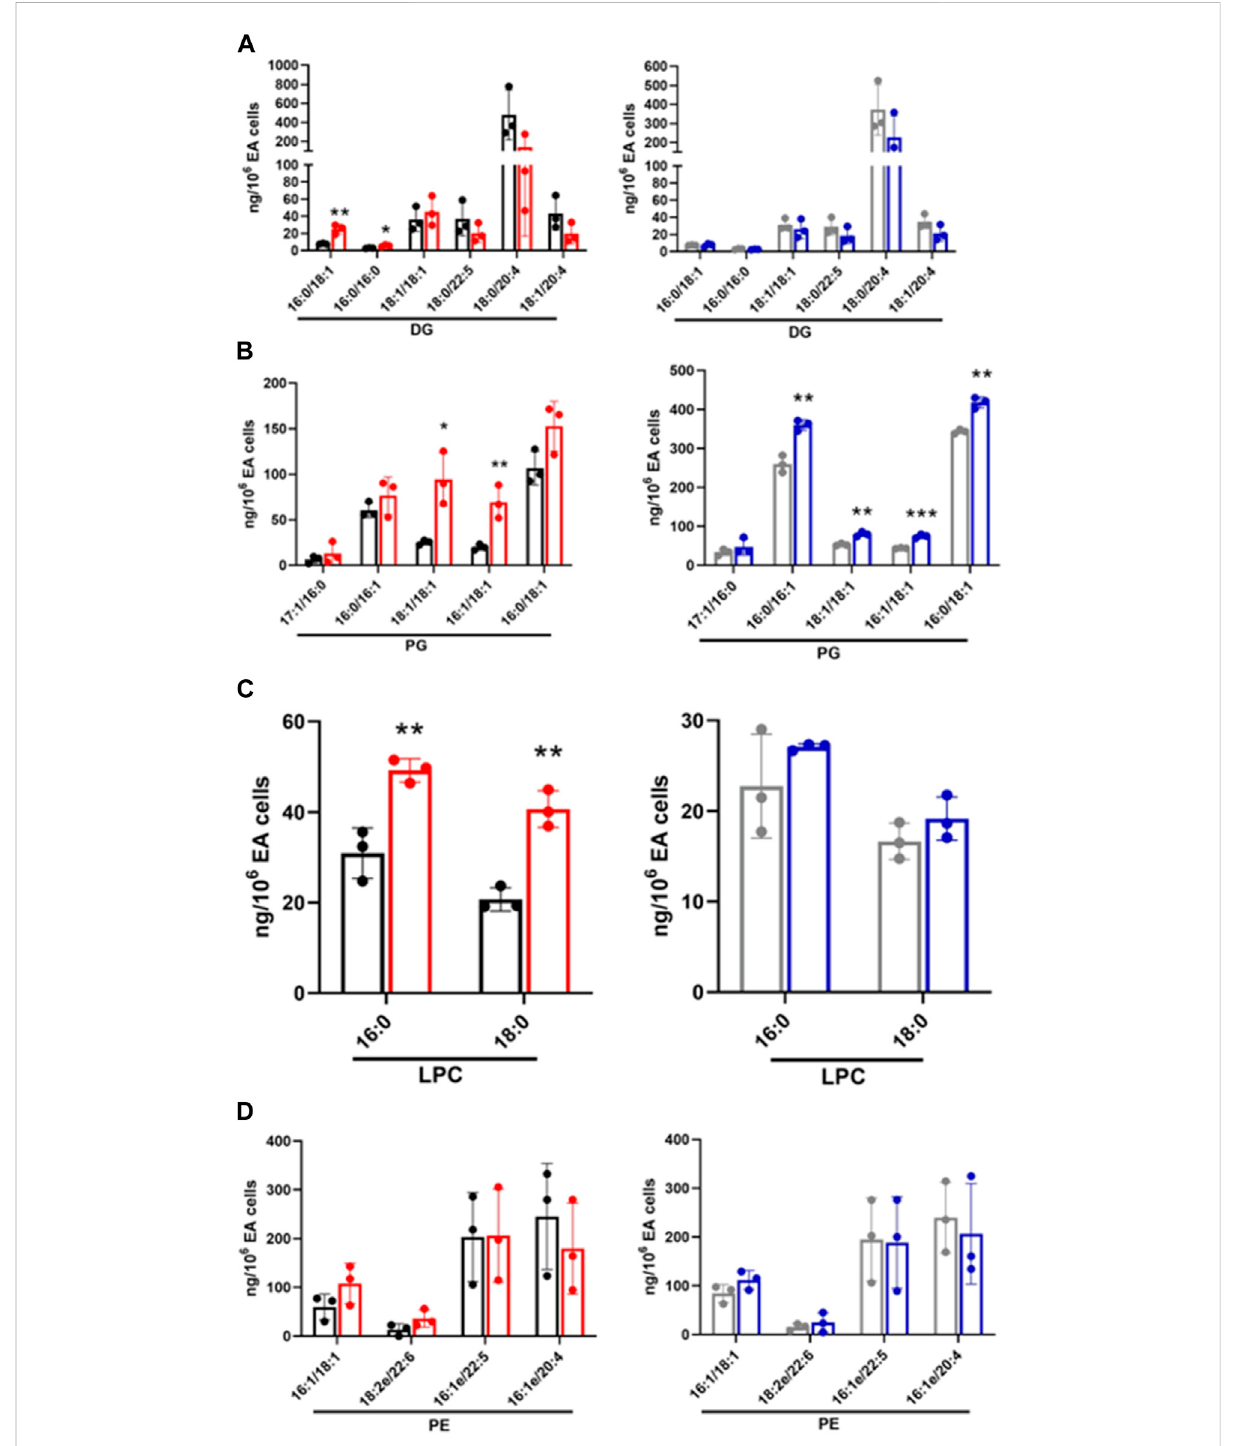
Targeted lipidomics ofendothelial and E. coli coculturefollowinga1 hincubation. Following untargetedlipidomic analysis,signi fi cantly altered lipids detected between cocultures and control conditions following a 1 h incubation were selected for targeted lipidomics. Lipid species were analyzed by PRM using Q Exactive MS/MS. DG (A) , PG (B) , and LPC (C) , and PE (D) were measured in CFT073 coculture (red), CFT073 combined control (black), JM109 coculture (blue) and JM109 combined control samples (gray). Statistics were performed using unpaired t -test, n = 3 for average of 3 biological replicates, p value: *** p < 0.001, ** p < 0.01, * p <